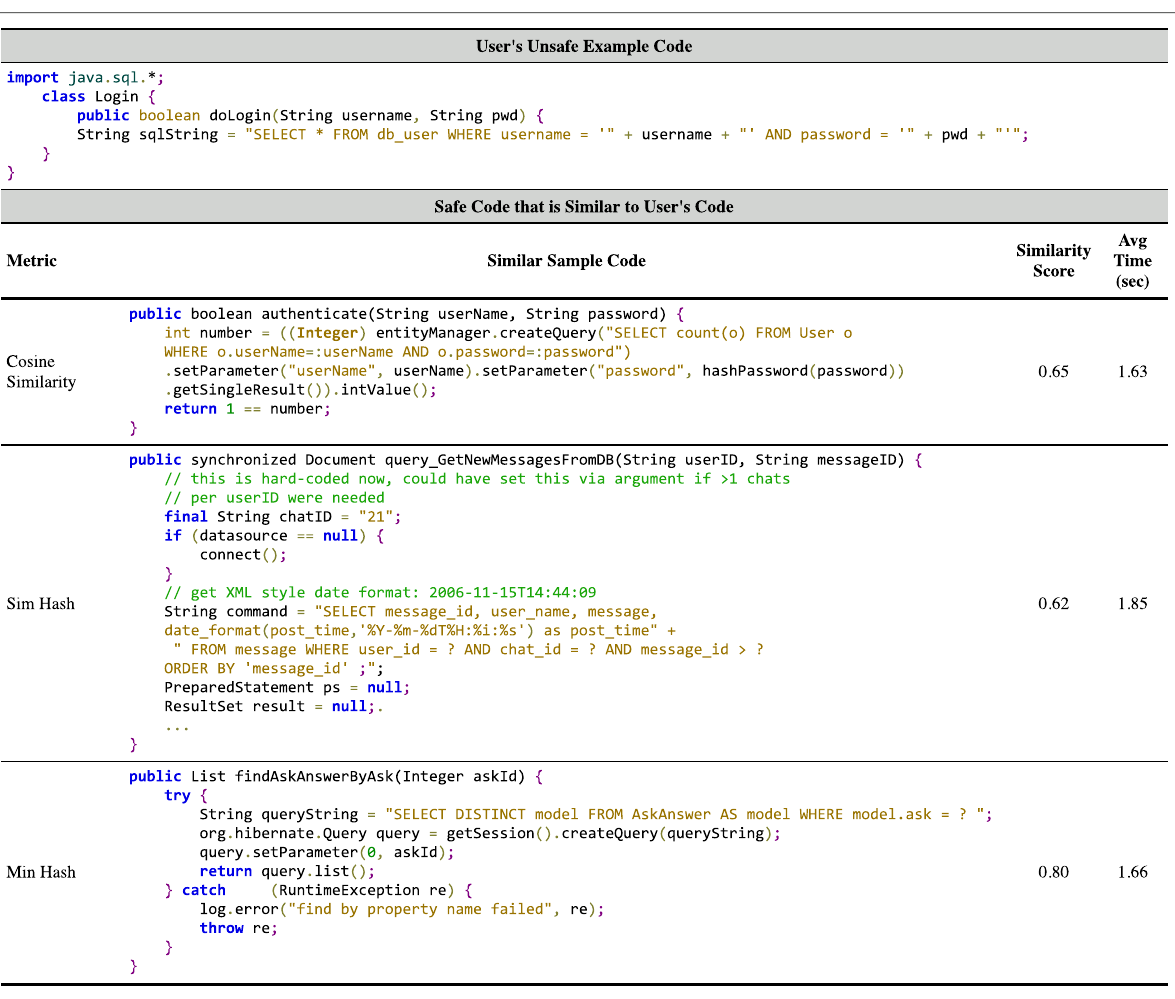
Fig. 9 Finding safe code that is most similar to the user’s